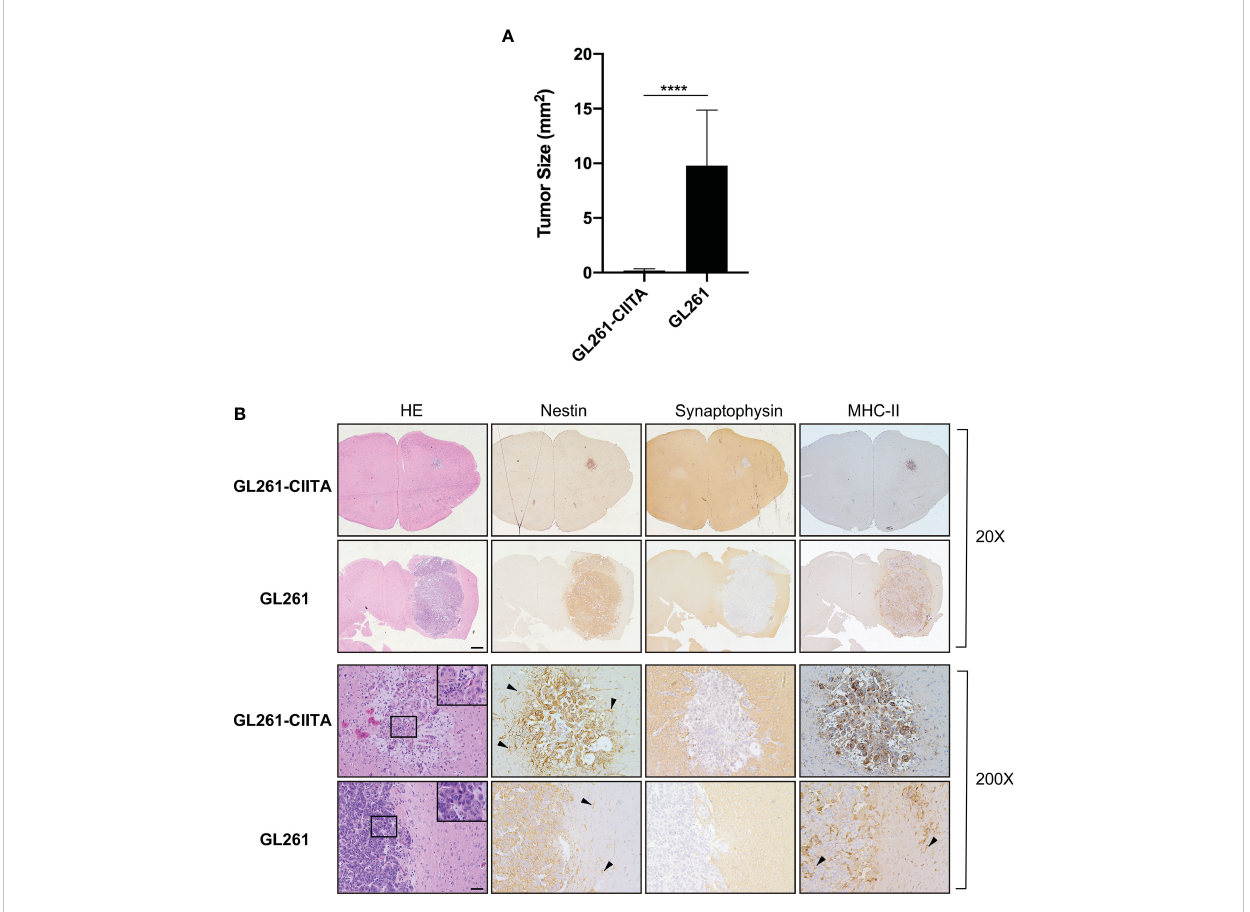
FIGURE 1 Intracranial implantation of MHC-II-positive GL261-CIITA tumor cells dramatically retarded tumor growth in vivo. C57BL/6 mice received intracranial injection of 3 × 10 4 GL261 (n = 7) or GL261-CIITA (n = 10) glioma cells. On day 21 after injection, mice were sacri fi ced, brains were removed, and serial sections of the brain were carried out to measure tumor size and for staining. (A) Average tumor size of GL261 and GL261-CIITA tumors. Data are represented as mean values, and error bars indicate the standard deviation (SD) within each group; n = 10. p -Values were determined via unpaired t-test; **** p < 0.0001. (B) HE and IHC staining of serial brain sections. The fi rst two series of upper panels were taken at ×20 magni fi cation; scale bar corresponds to 500 m M. The third and fourth series of horizontal panels were taken at ×200 magni fi cation; scale bar corresponds to 50 m M. Small square boxes are the areas represented in the corresponding large square boxes at ×400 magni fi cation of each IHC image. Note that selected areas in IHC images of GL261 parental tumors are taken as representative of high mitotic cell rate. Arrowheads in the nestin-stained panels point to astrocytes, and in the MHC-II stained panel to myeloid cells. HE, hematoxylin and eosin; IHC,